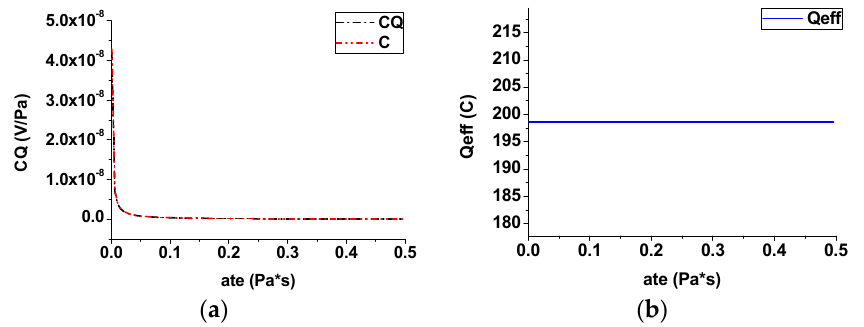
Figure 4. Effect of the viscosity (steady case): ( a ) streaming potential coupling coefficient; ( b ) effective net residual charge density.